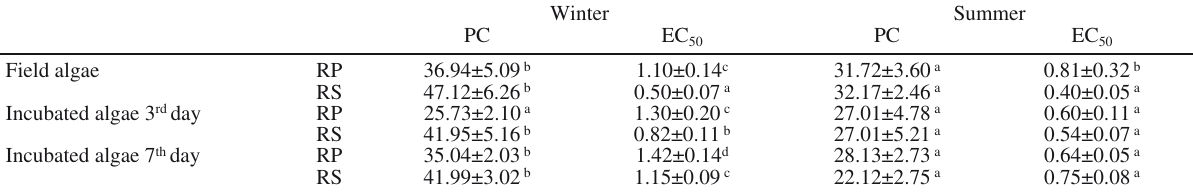
Table 6. – Content of phenolic compounds (PC) expressed as mg g –1 DW and antioxidant activity as EC (mg DW mL –1 , DPPH method) 50 in C. tamariscifolia collected in winter (February) and summer (July) from rocky shores (RS) and rockpools (RP) from field material (field algae) and after 3 and 7 d incubation in 1.5-L cylindrical vessels under solar radiation (incubated algae). Data are expressed as mean±standard deviation of n=6 and lower-case letters denote significant differences after SNK test.